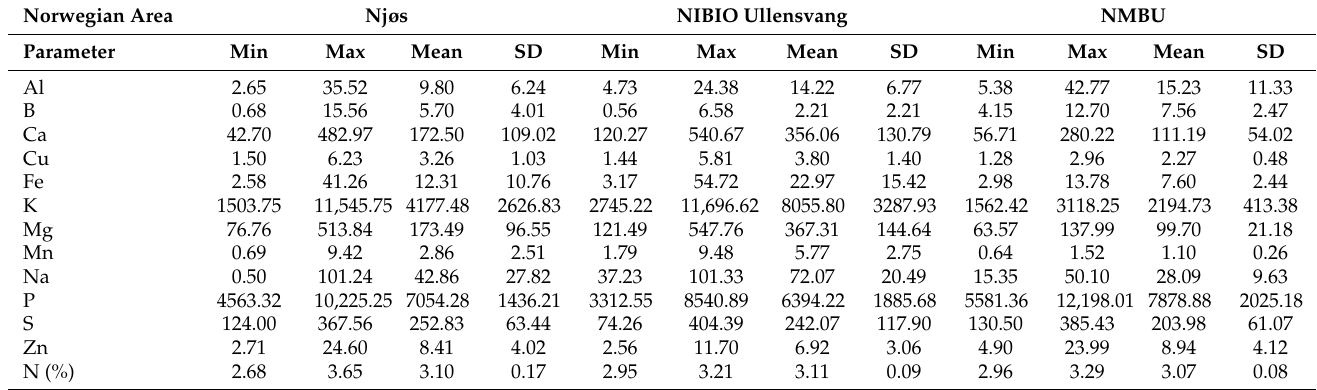
Table 2. Descriptive analysis of the content of nutrients (mg/kg) in 68 Norwegian plum cultivars from Njøs (42 samples) and NIBIO Ullensvang (8 samples) collected in 2019 and 2021, and from NMBU (18 samples) collected in 2019 and